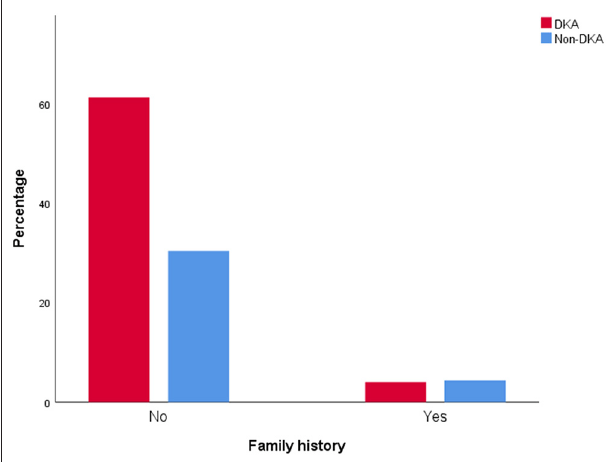
FIGURE 4 | Percentage of family history positive in DKA and non-DKA groups respectively.